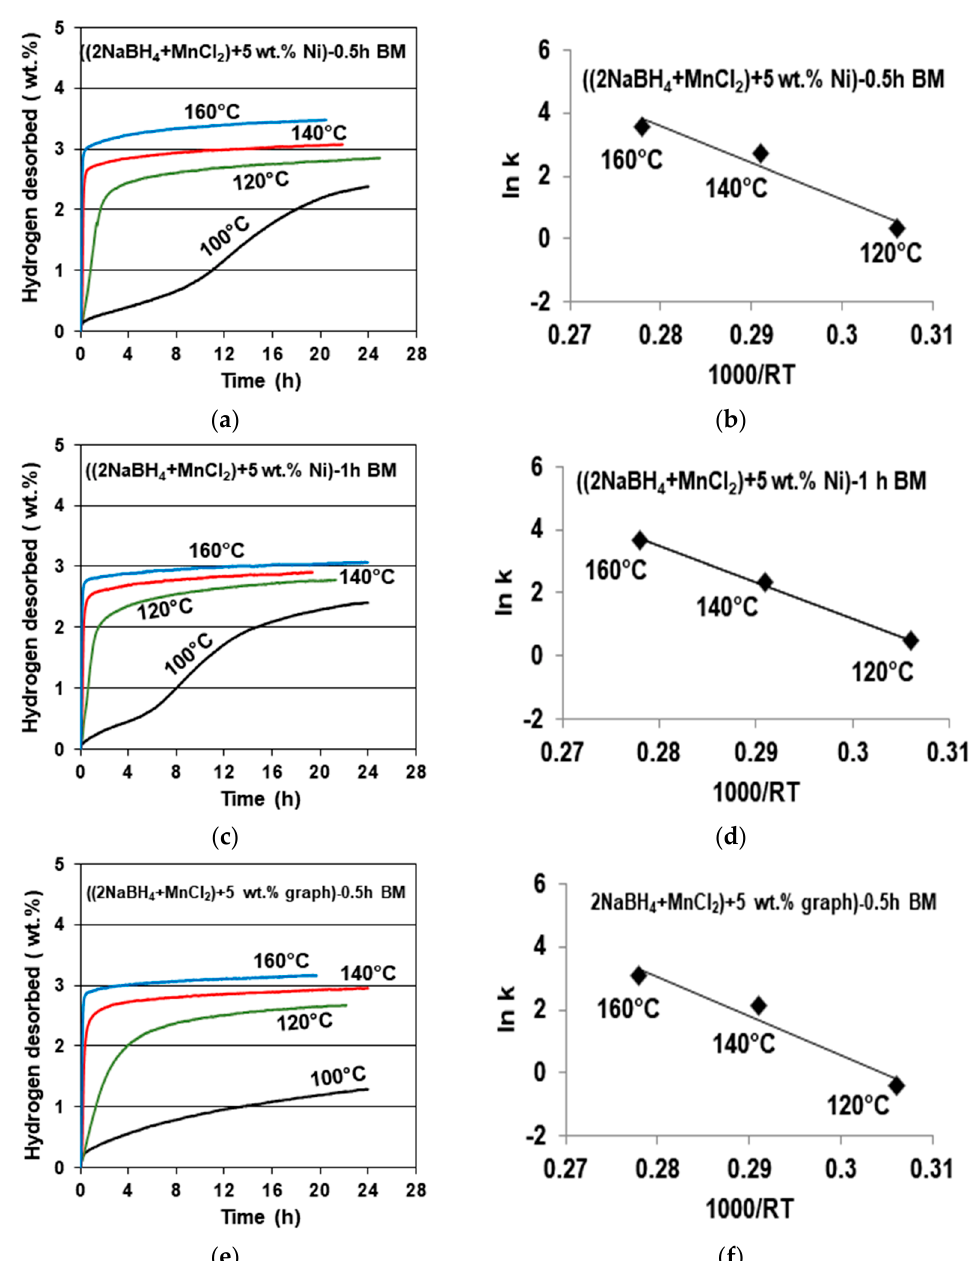
Figure 4. Desorption curves for the (2NaBH 4 + MnCl 2 ) samples milled with additives: ( a ) filamentary Ni for 0.5 h BM; Q TR = 36.4 kJ/g; ( b ) corresponding Arrhenius plot of rate constant k with temperature for estimation of the apparent activation energy (AAE) of hydrogen desorption for 0.5 h BM 5 wt. % Ni: y = − 116.68 + 36.24, R 2 = 0.948; ( c ) filamentary Ni for 1 h BM; Q TR = 72.8 kJ/g; ( d ) corresponding Arrhenius plot for 1 h BM 5 wt. % Ni: y = − 115.19 + 35.759; R 2 = 0.998; ( e ) graphene for 0.5 h BM; Q TR = 36.4 kJ/g; ( f ) corresponding Arrhenius plot for the 0.5 h BM 5 wt. % graphene sample: y = − 125.93 + 38.323; R 2 = 0.996.